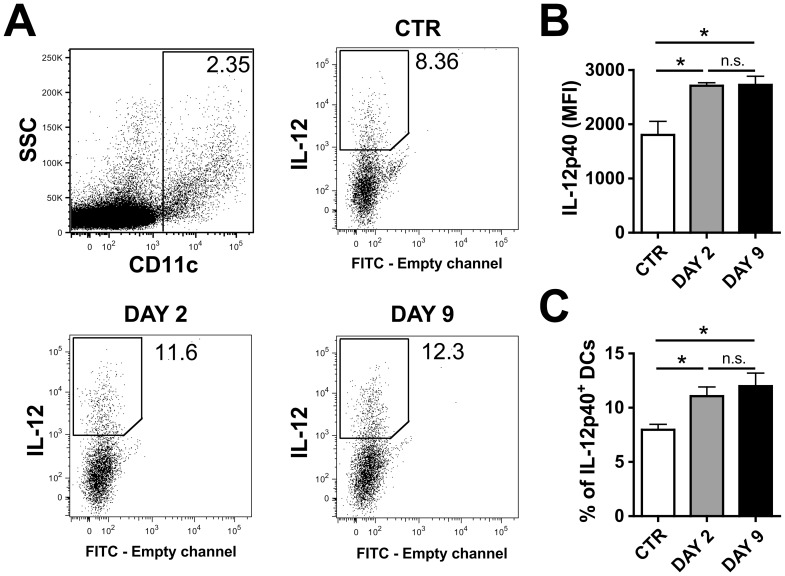
DCs in LNs draining sites of skin inflammation in WT mice upregulate IL-12/23p40 expression.Intracellular FACS analysis of IL-12/23-p40 in CD11c+ DCs present in LNs draining uninflamed control (CTR) or DAY 2- or DAY 9-inflamed ear skin of WT mice. (A) Representative FACS plots of the different groups are shown. (B) The MFI of IL-12/23-p40 staining on CD11c+ DCs was significantly higher in DCs present in LNs draining DAY 2- and DAY 9-inflamed ear skin as compared to LNs draining CTR skin. (C) Furthermore, a greater percentage of DCs in inflammation-dLNs stained positive for IL-12/23-p40 expression as compared to DCs in control LNs. Representative data from 1 out of 2 similar experiment (n = 3 mice/group) are shown. *p<0.05.